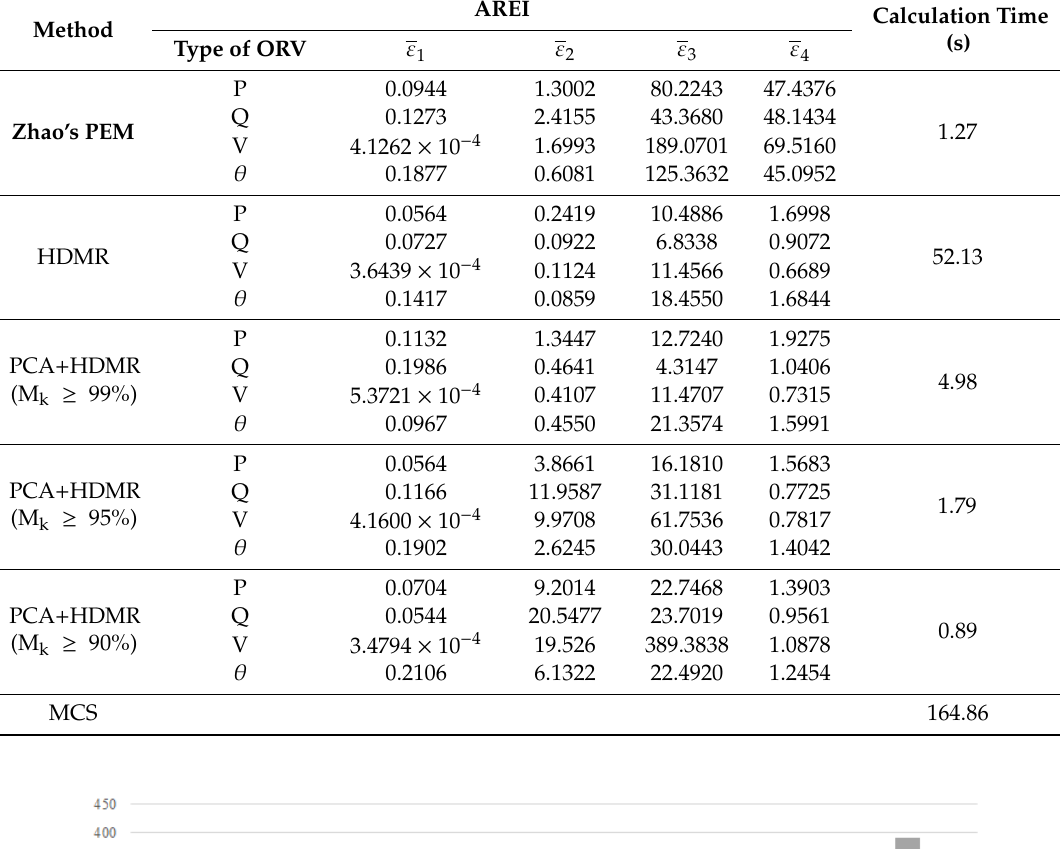
Table 3. Performance of evaluated methods (IEEE-30).